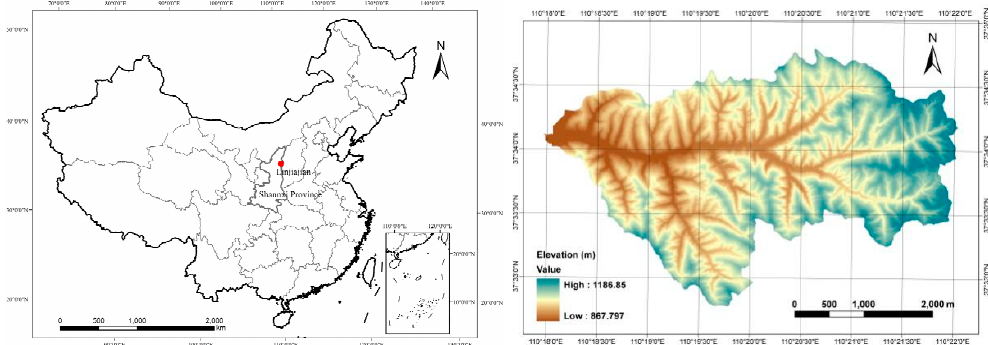
Figure 2. Study Area and Data of Linjiajian.